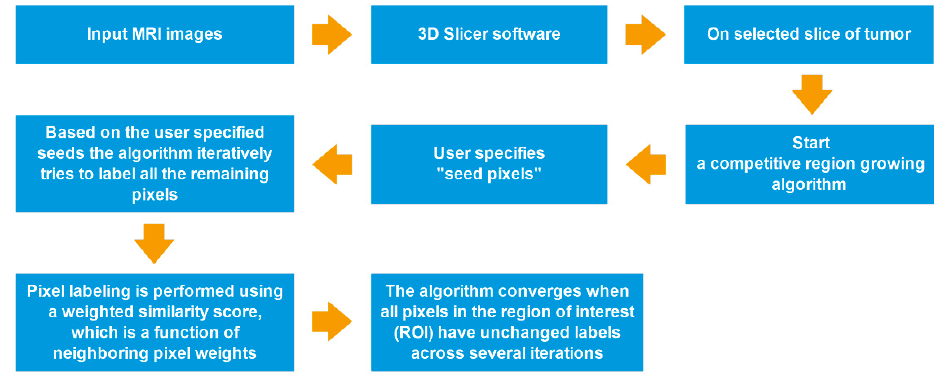
Figure 3. Process-flow diagram of a competitive region growing algorithm.